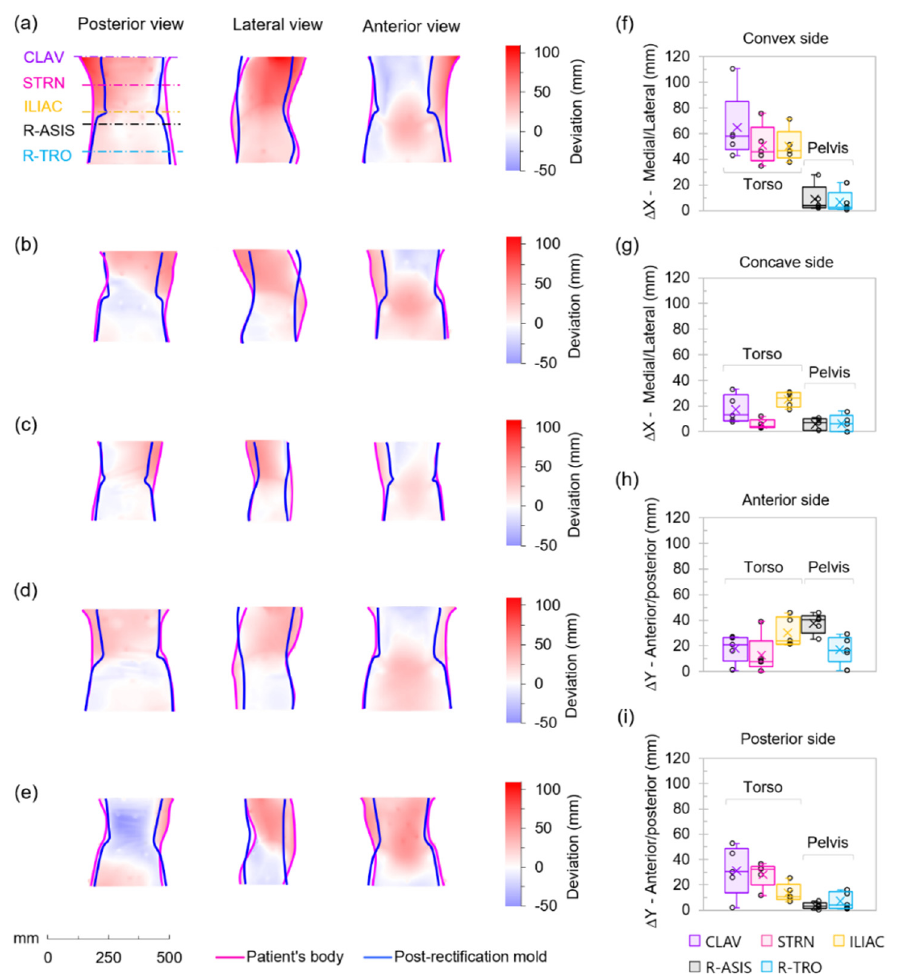
Figure 6. Centroid locations of the body scan, pre-, and post-rectification mould scans for the differ- ent patients. ( a – d ) are the coordinates of the centroids at each transverse section for all the patients. ( e , f ) are the centroid trajectories from the posterior and lateral view, respectively.